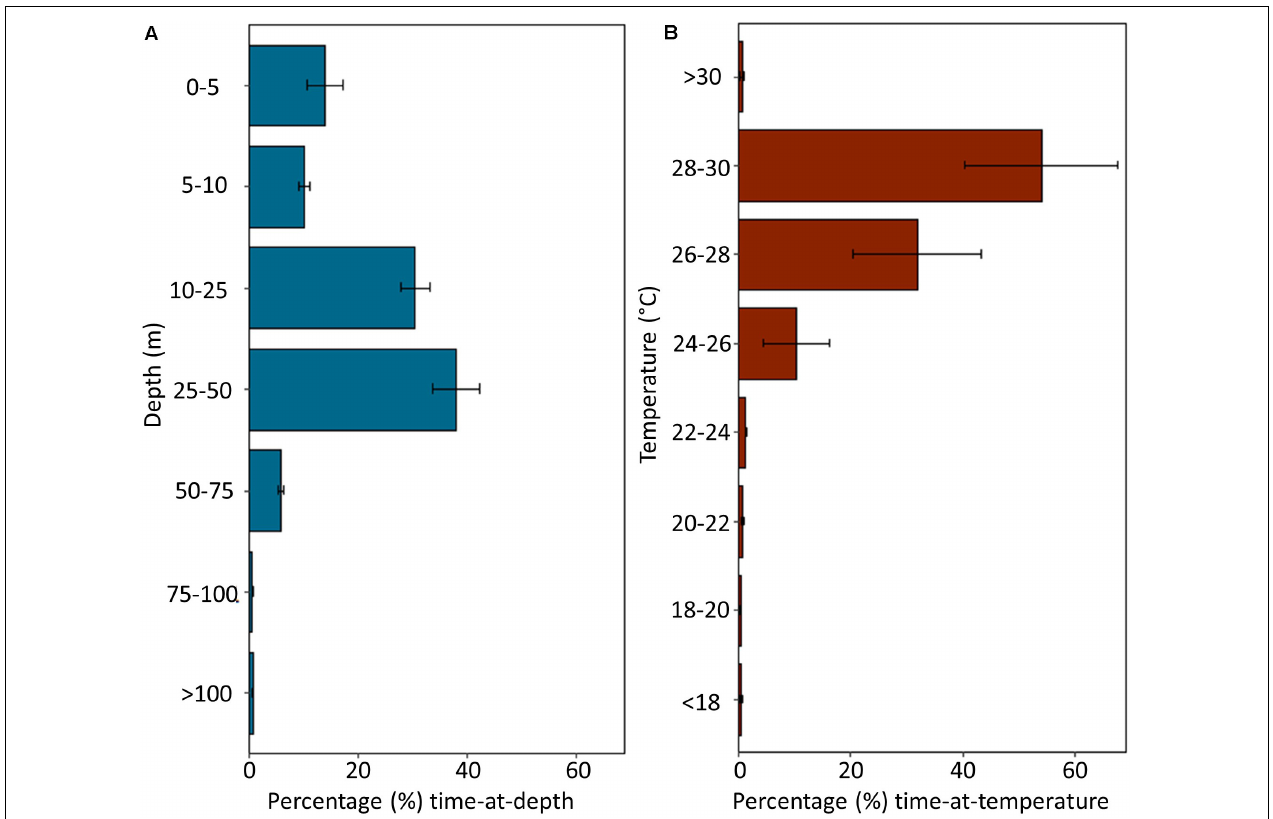
FIGURE 4 | Summarized depth and temperature data recorded by MiniPAT tags deployed on four silky sharks ( Carcharhinus falciformis ) tagged around the Chagos Archipelago. Histograms represent mean percent time spent at (A) depth and (B) temperature. Error bars indicate ± one standard